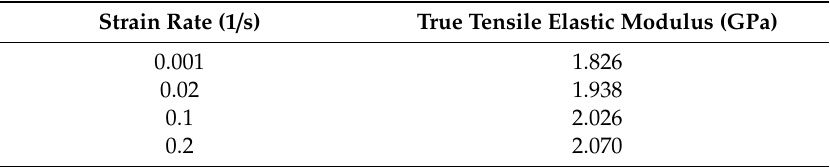
Table 1. Tensile elastic modulus of ABS with strain rates.